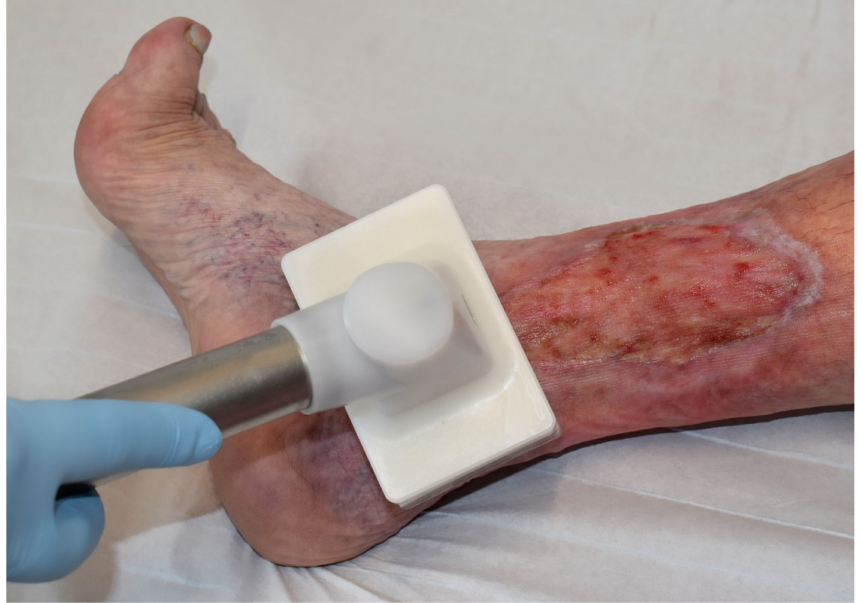
Figure 2. Application of the DBD plasma device PlasmaDerm ® (CINOGY GmbH, Duderstadt, Germany) to a venous ulcer on the lower leg. The advantage of the DBD device is coverage of a greater treatment area. The flexible sponge electrode is ideal for flat wounds.